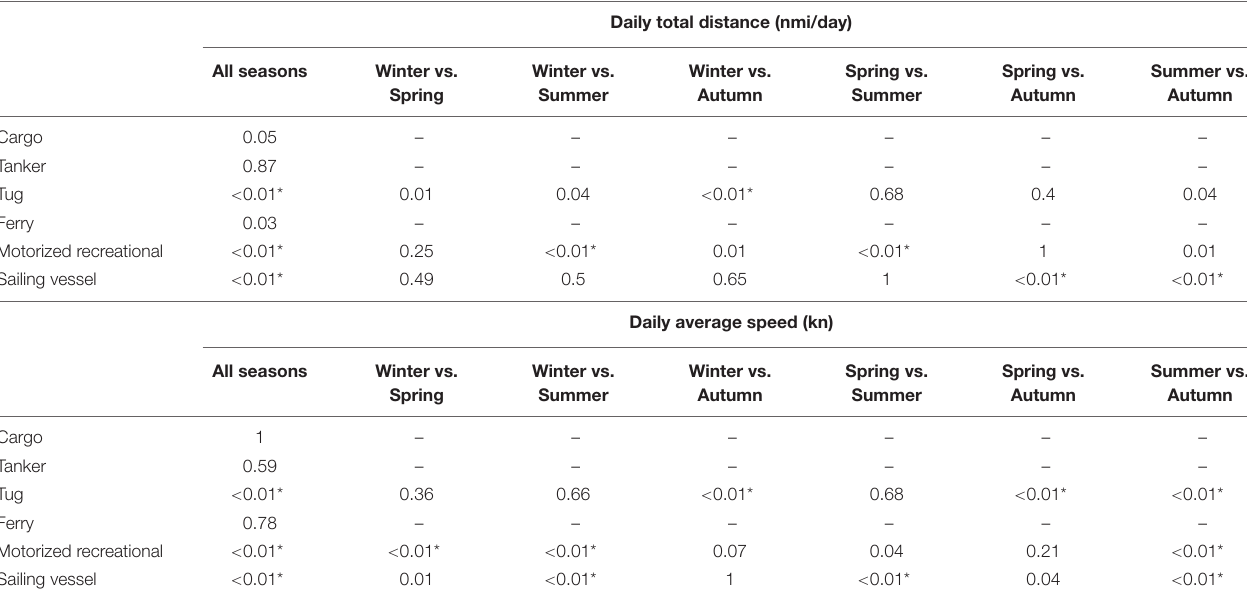
TABLE 2 | Mood’s median test results ( p -values) comparing daily total distance traveled (nmi/day) and daily average speed (kn) across seasons and post hoc analysis between